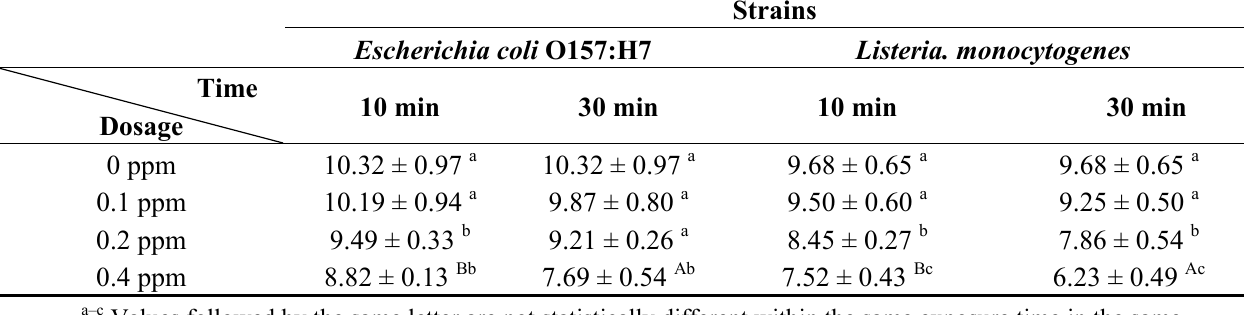
Table 2. Mean (standard deviation) bacterial counts in log cfu/mL of E. coli O157:H7 and L. monocytogenes in starch solution containing 0.1, 0.2, and 0.4 ppm of ozone at 10 and 30 min exposure